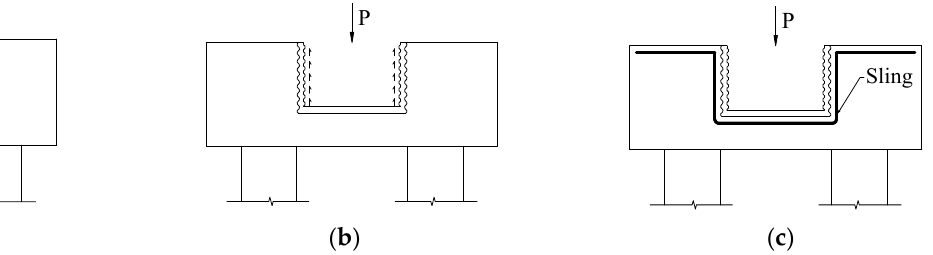
Figure 25. Components of vertical bearing capacity. ( a ) Bottom plate bending; ( b ) side wall shear key; ( c ) hanging bar suspension.